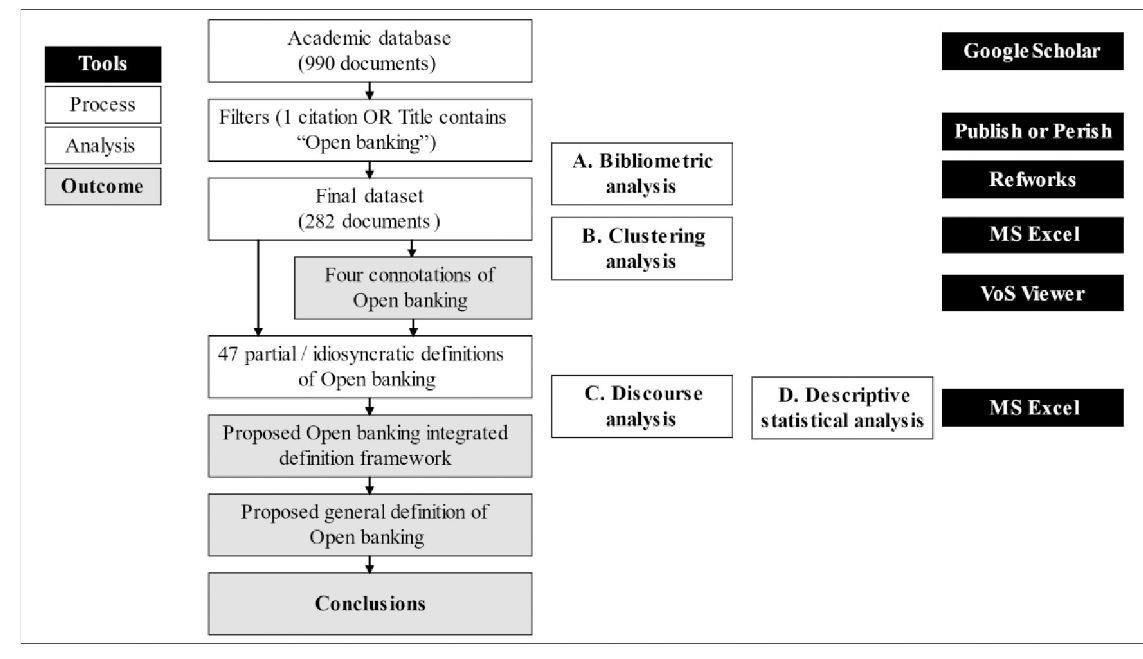
Fig 1. Overview of the